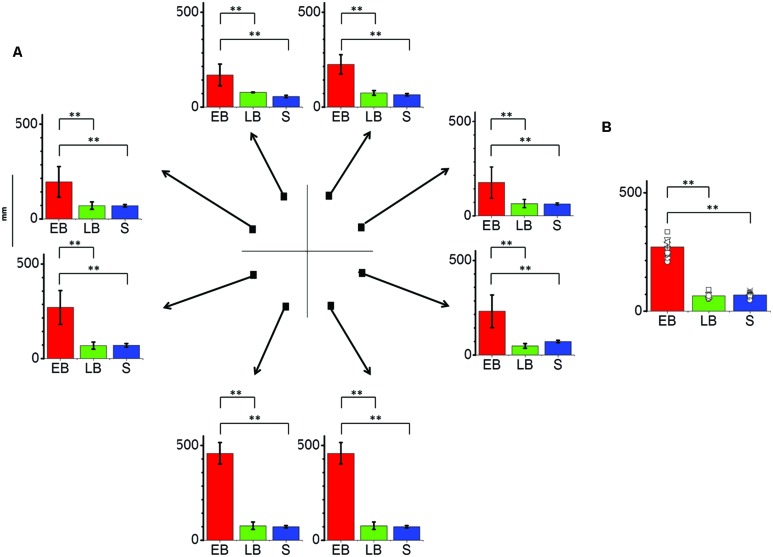
Significant differences are illustrated (∗∗p < 0.01). (A) Average localization error (±SE) for each position and as average across trials for all participants. EB individuals (EB, N = 12) perform far worse the task in comparison to LB individuals (LB, N = 8) or sighted blindfolded controls (S, N = 20), presenting an error over 150 mm in every position and peaking at the lower side positions. (B) Average localization error among groups as average across trials and points. EB show an error more than twice bigger than LB and controls.